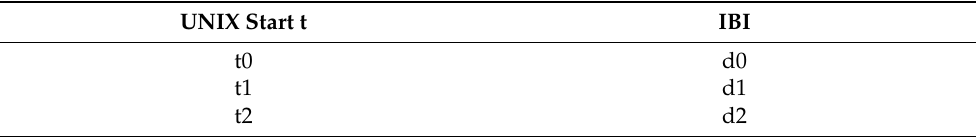
Figure 4. Inter ‐ beat ‐ intervals calculation. The green dots show valid peaks while red dots show the discarded peaks. Table 2. Inter ‐ beat ‐ intervals in IBI.csv file (unit = μ S). Table 2. Inter-beat-intervals in IBI.csv file (unit = µ